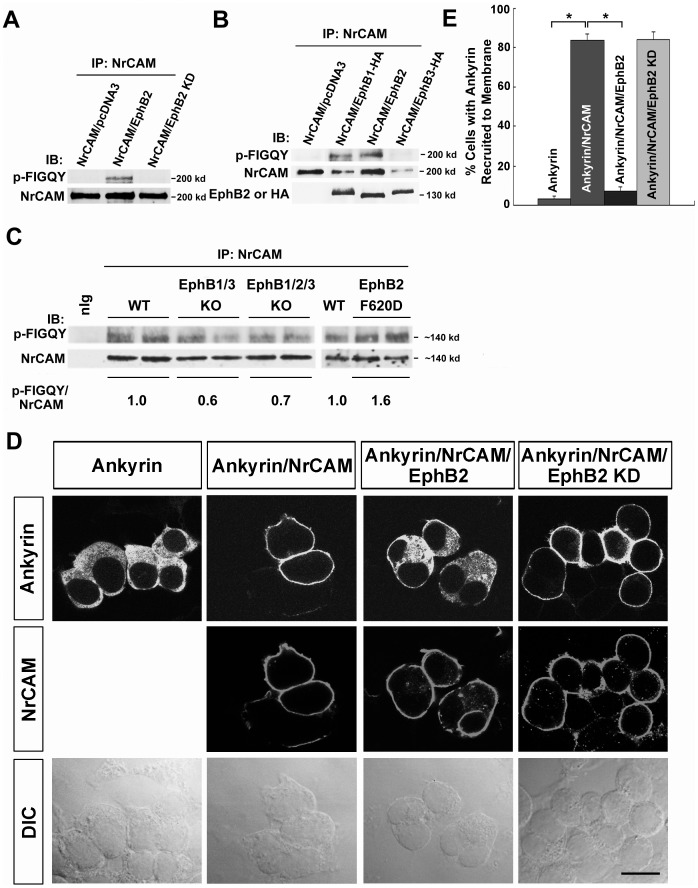
EphB receptors Induce Tyrosine Phosphorylation of NrCAM at the FIGQY Motif, and Inhibit Ankyrin Recruitment in HEK293 cells.
A. NrCAM was expressed with or without EphB2 or EphB2 kinase dead mutant (EphB2 KD) in transfected HEK293 cells, followed by immunoprecipitation with NrCAM antibodies and immunoblotting with phospho-FIGQY antibodies. EphB2 induced phosphorylation of NrCAM (200 kD) at FIGQY (p-FIGQY) compared to NrCAM alone or to co-expression of the EphB2 kinase dead mutant. Blots were stripped and reprobed with antibodies to NrCAM to indicate relative levels of NrCAM in the immunoprecipitates. B. NrCAM was expressed with or without EphB1, EphB2, or EphB3 in transfected HEK293 cells, followed by immunoprecipitation with NrCAM antibodies and immunoblotting with phospho-FIGQY antibodies. EphB1 (HA-tagged) or EphB2 (not HA-tagged) induced effective phosphorylation of NrCAM at FIGQY, whereas EphB3 (HA-tagged) had a weak effect. Blots were stripped and reprobed with antibodies to EphB2 or to the HA-epitope on EphB1 and EphB3. Each EphB receptor was co-immunoprecipitated efficiently with NrCAM. C. Lysates of the superior colliculus from WT, EphB1/3 double null, EphB1/2/3 triple null and constitutively active EphB2 (F620D) homozygous mice (P2-P3) were immunoprecipitated with antibodies to NrCAM, and immunoblotted with phospho-FIGQY or NrCAM antibodies. Bands were quantified using the threshold function of ImageJ. The numbers under the blots represent the normalized average phospho-FIGQY/NrCAM band intensity from individual mice. Phosphorylation of NrCAM at FIGQY was reduced in the SC of EphB1/3 and EphB1/2/3 null mice compared to WT, while phospho-FIGQY on NrCAM was increased in the EphB2 F620D mice. D. Cytofluorescence assay for recruitment of ankyrinG-EGFP to NrCAM in the plasma membrane of transfected HEK293 cells was visualized by confocal imaging. Boxes above images indicate the expression plasmids used for transfection, while boxes at the left indicate fluorescence labeling of ankyrinG-EGFP or NrCAM in the same cells. Corresponding differential contrast (DIC) images are shown below. AnkyrinG-EGFP localized within the cytoplasm of cells expressing ankyrin alone, while co-expression of NrCAM led to the recruitment of ankyrinG-EGFP to the cell membrane, where NrCAM was localized. When NrCAM was co-expressed with EphB2, ankyrinG-EGFP remained largely present in the cytoplasm. When NrCAM was co-expressed with EphB2 KD, ankyrinG-EGFP was recruited to the plasma membrane where NrCAM was localized in most cells, although occasionally some cytoplasmic localization was seen. Scale bar = 15 µm. E. Quantification of the percentage of cells with ankyrinG-EGFP recruited to the plasma membrane of HEK293 cells transfected as in C. NrCAM expression significantly increased ankyrinG-EGFP recruitment to the plasma membrane in ankyrin/NrCAM-expressing cells as compared with ankyrin expression alone (Ankyrin/NrCAM: 84±3%; Ankyrin: 3±1.6%). In cases of ankyrin/NrCAM/EphB2 co-expression, ankyrinG-EGFP recruitment was strongly decreased (7±2%) compared to ankyrin/NrCAM expression. There was no significance decrease in ankyrinG-EGFP recruitment in cases of ankyrin/NrCAM/EphB2 KD co-expression (84±4%). Error bars show S.E.M. Asterisks indicate significant differences in means (one-way ANOVA, Tukey’s post-hoc test, *p<0.001).